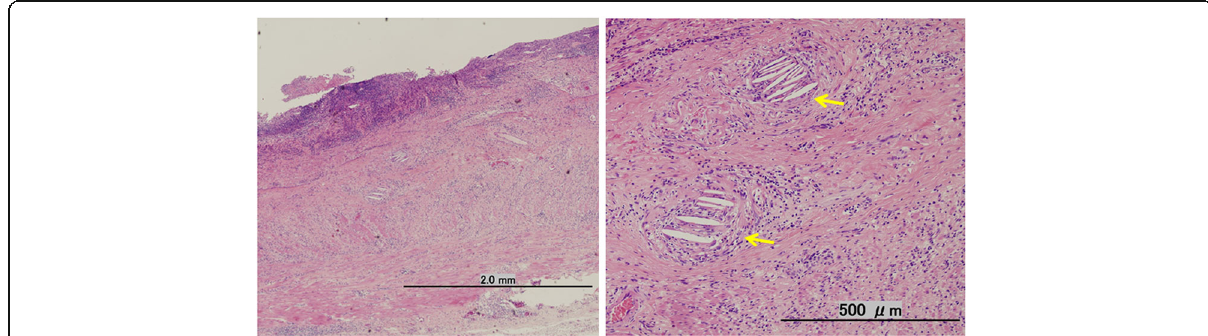
Fig. 5 Histopathological findings revealed fibrotic changes to the whole bowel wall, and needle-shaped cholesterol crystals were observed in the submucosal layer of the stenotic site